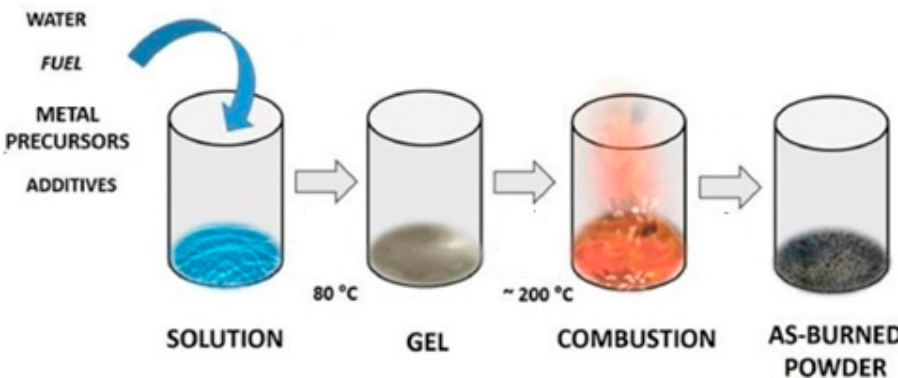
Figure 20. Schematic showing the steps in a typical combustion process (Adapted from